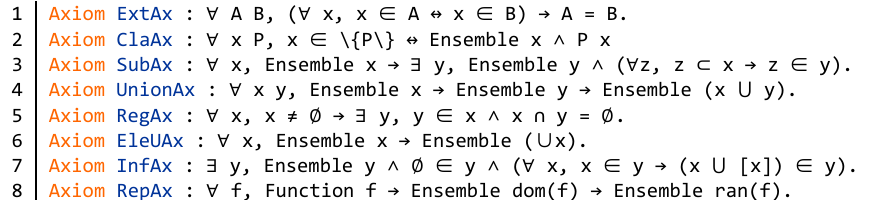
Figure 1. The formalization of the eight axioms in the MK set